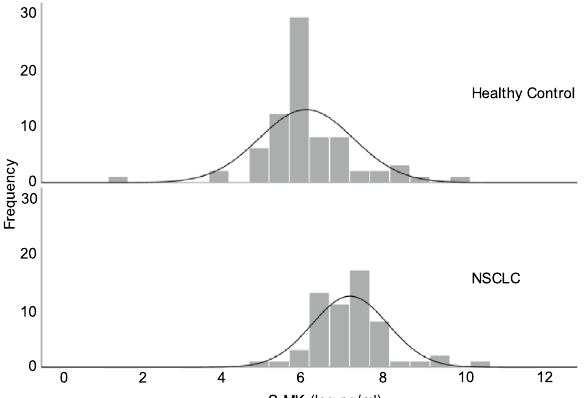
Figure 1. Frequency distribution of S-MK concentration in healthy adults and patients with NSCLC. Abbreviations: S-MK serum-midkine, NSCLC non-small lung cancer, pg picogram, ml milliliter. Data displayed as a log-scaled histogram overlaid with a normal distribution curve. Levene’s test was used to confirm the equality of variances (p = 0.58).